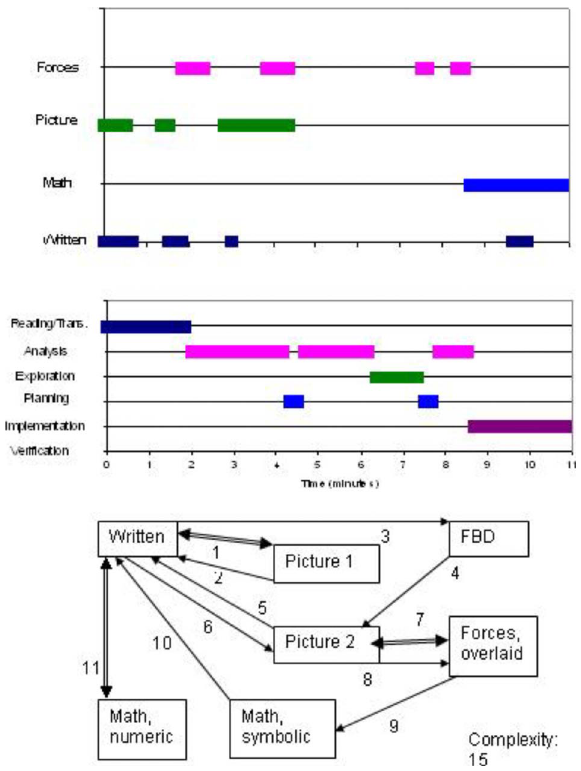
FIG. 9. (cid:1) Color online (cid:2) Three codings of novice Sam’s successful solution of the electrostatics challenge